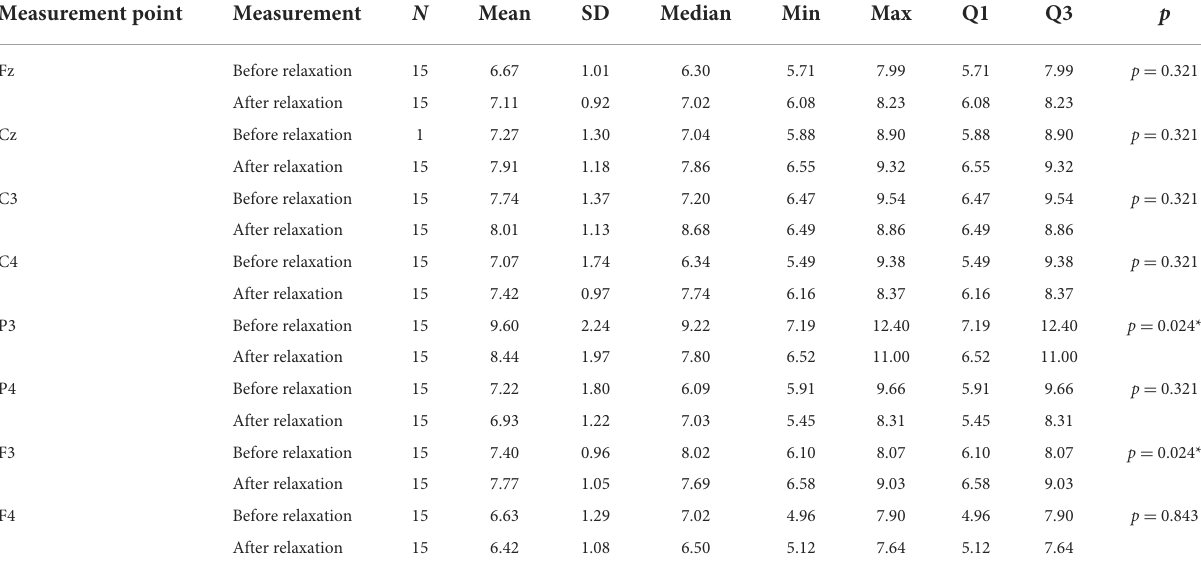
TABLE 3 Comparison of Beta 1 wave amplitudes before the SKY course (the first day) and after the whole SKY course (third day) with eyes open. Measurement